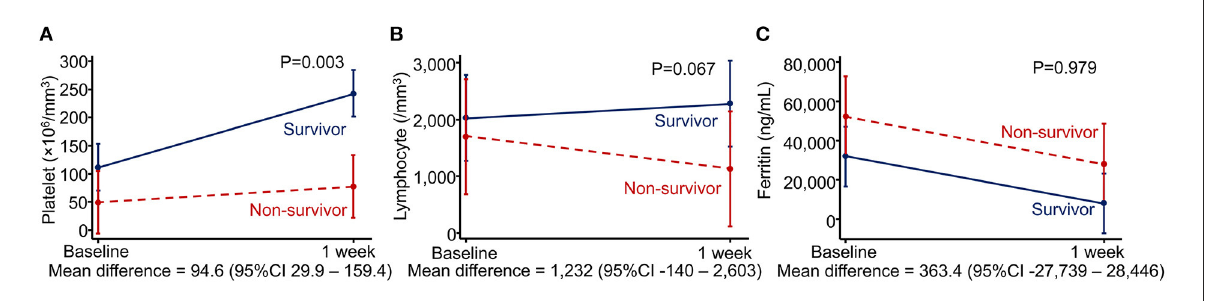
FIGURE2 Associations between changes in laboratory parameters and mortality using mixed-model analysis. (A) Platelet count, (B) lymphocyte count, and (C) ferritin